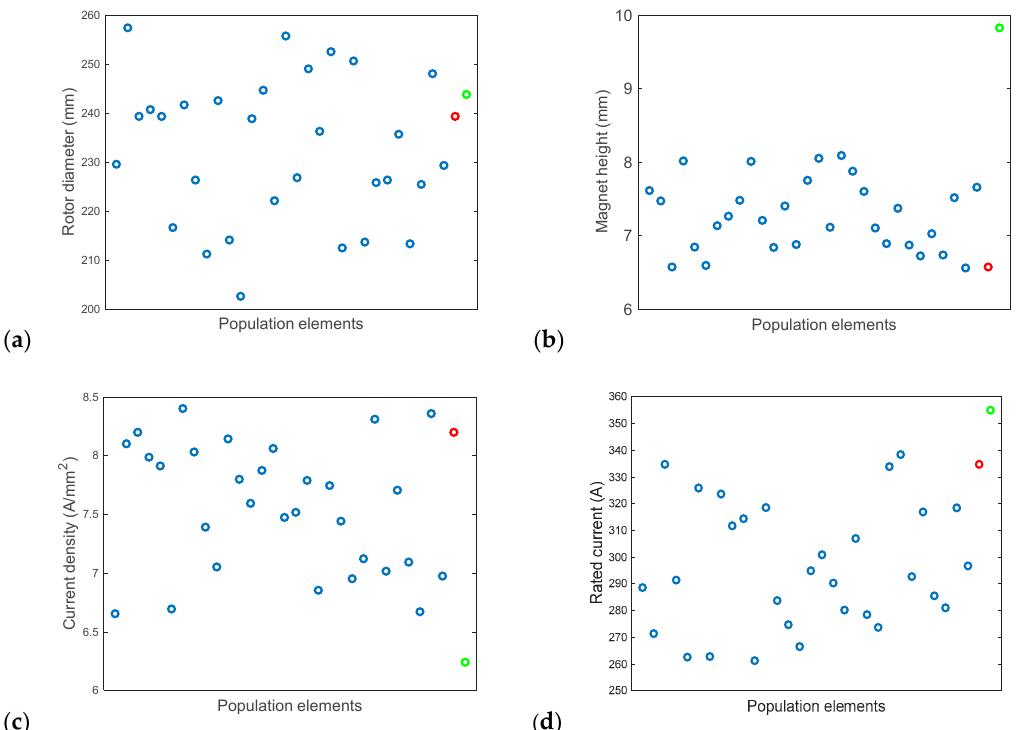
Figure 10. Initial population distribution (blue circles), final solution with best power density (red circle) and with highest rated power (green circle): ( a ) Rotor external diameter (mm); ( b ) current density (A / mm 2 ); ( c ) magnet height (mm); ( d ) rated current (A).